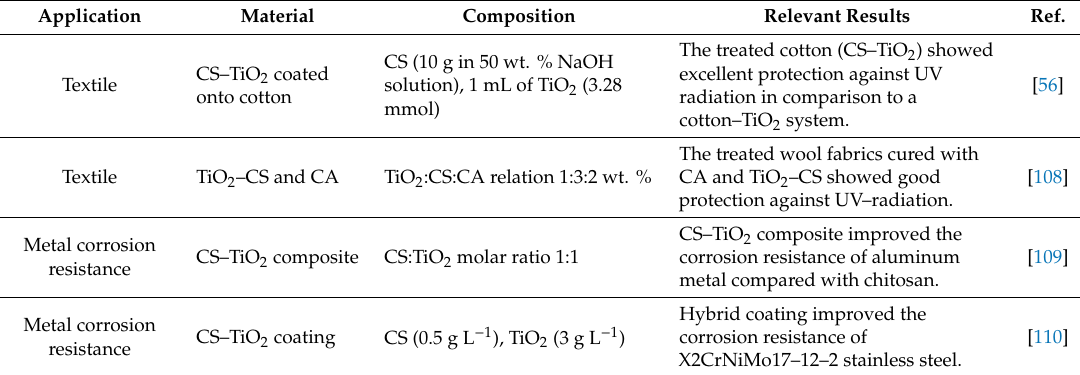
Table 8. Textile and anti-corrosive applications of CS–TiO 2